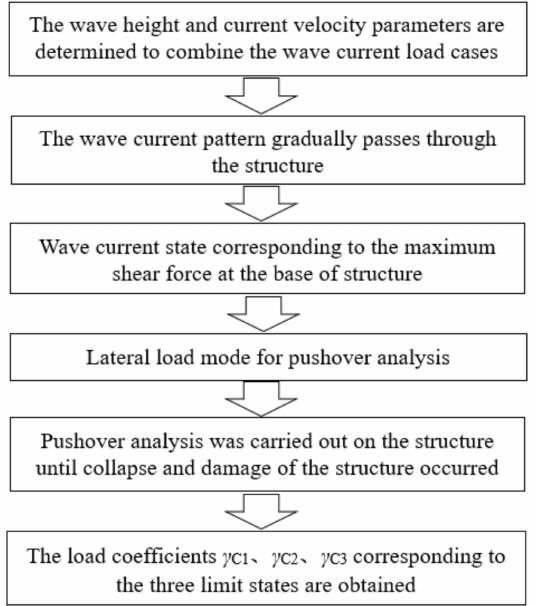
Figure 3. The basic method workflow for evaluating the performance of OSTs under the combined action of wave and current